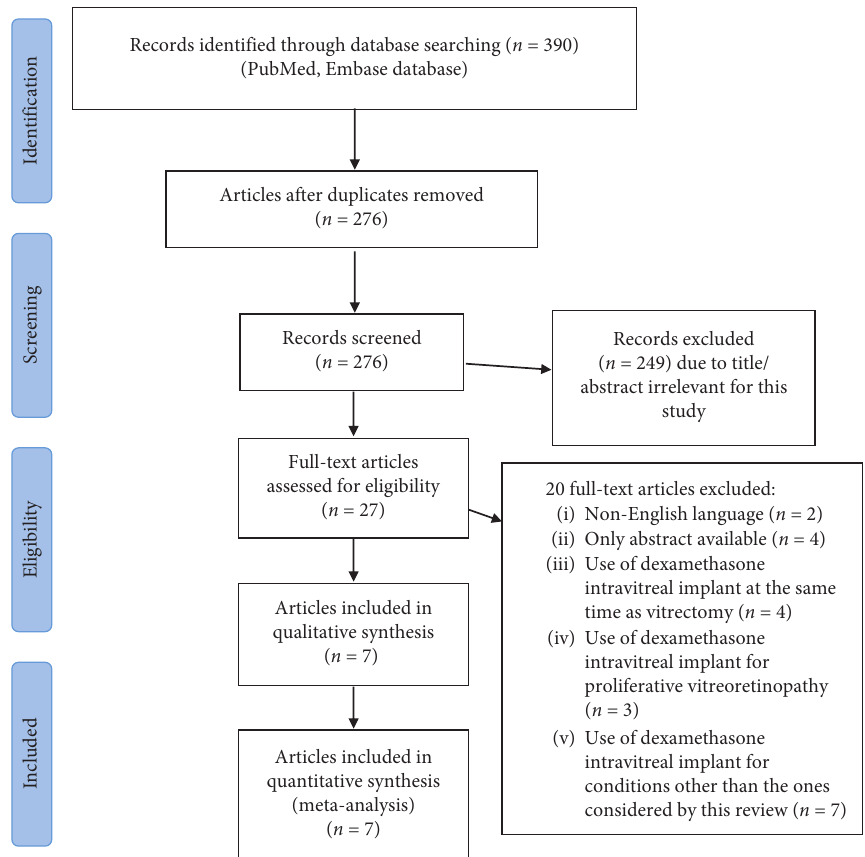
Figure 1: Flow diagram of the study selection